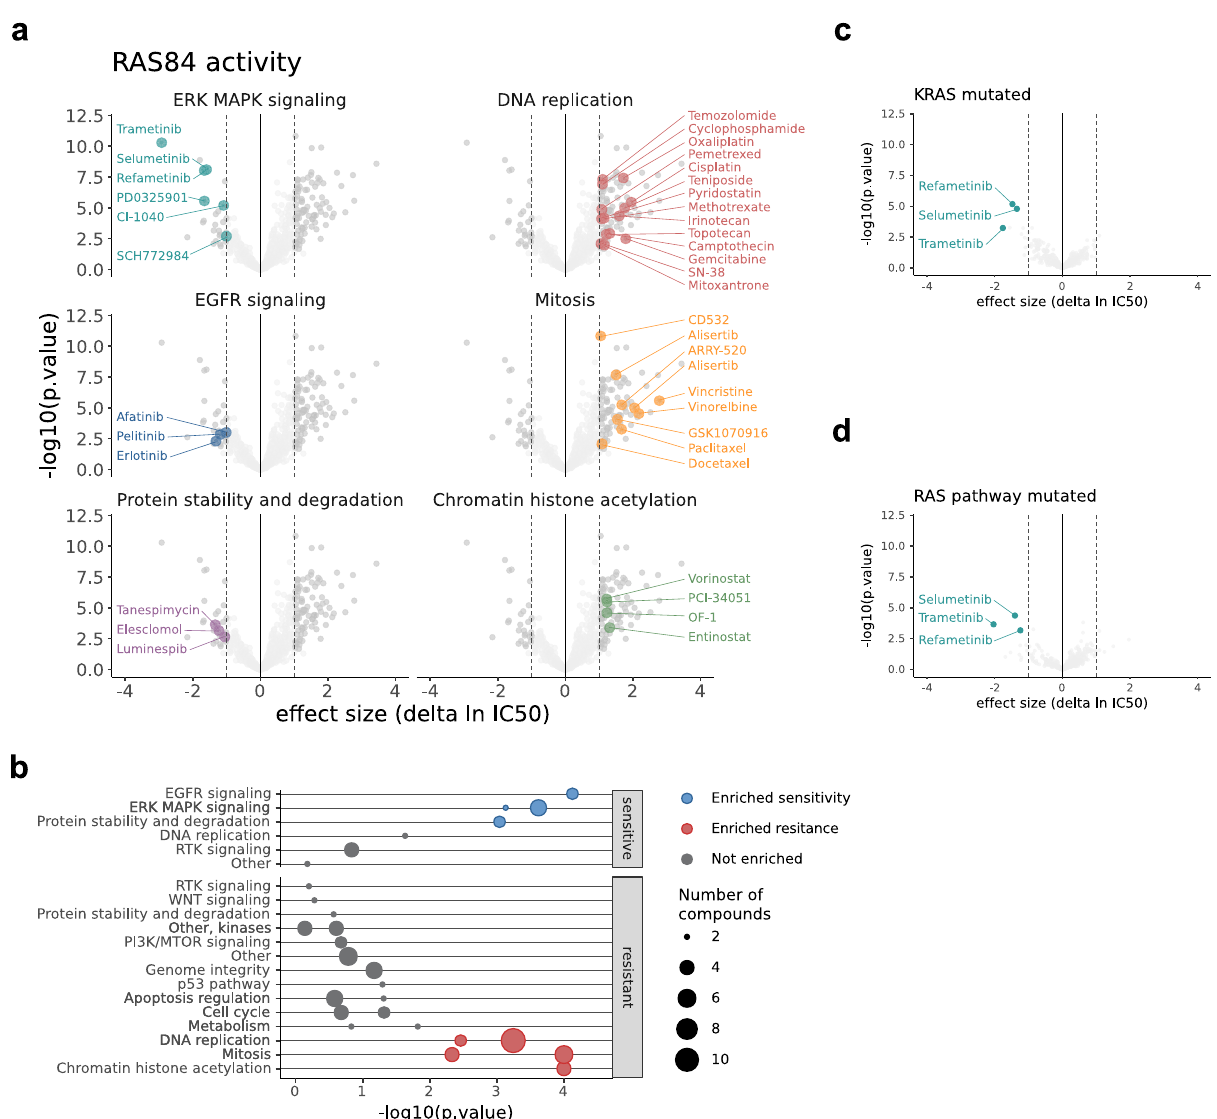
terms enriched in the sensitive drugs are shown in blue, the resistant in red. The number of drugs in each group is indicated by the size of the point. All tested targets are shown. c , d Volcano plots showing differences in IC50 values between KRAS mutant and wild-type cell lines and RAS pathway mutated and wild-type cell lines (linear model with Benjamini – Hochberg correction). Drugs with enriched target annotations in the signi fi cant sensitive and resistant groups are highlighted (hypergeometric